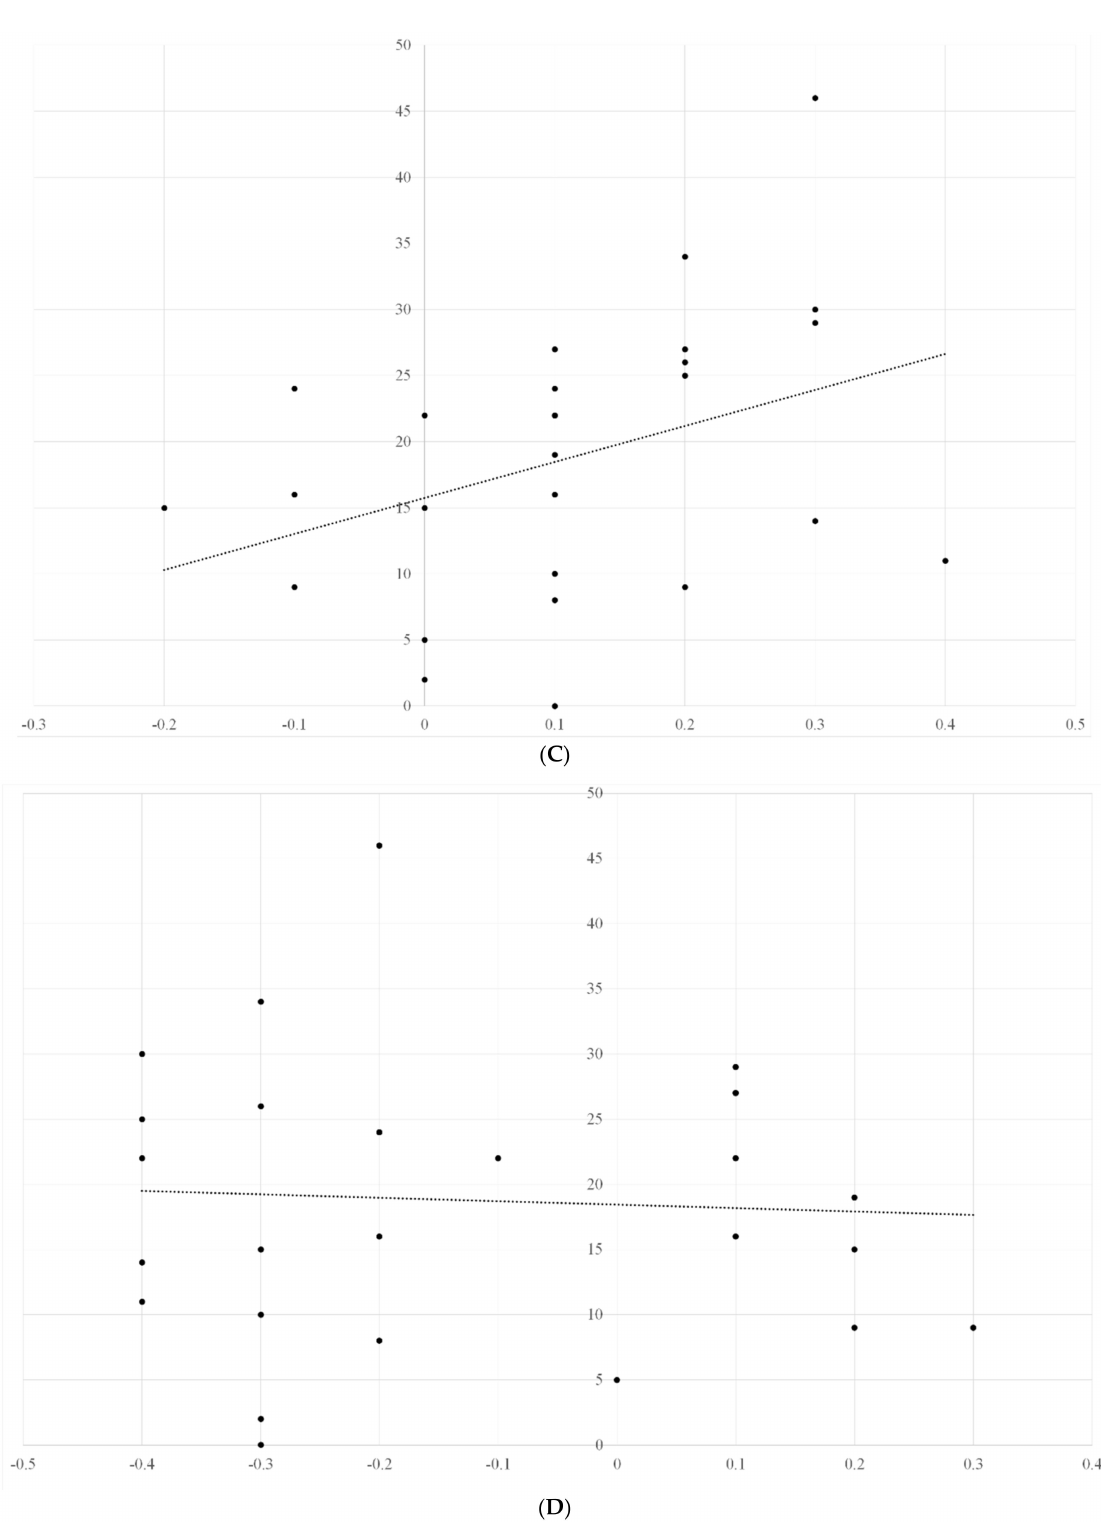
Figure 2. ( A ) Relationship between changes in nutritional status and ADL recovery in male patients; ( B ) relationship between changes in muscle strength and ADL recovery in male patients; ( C ) rela- tionship between changes in muscle quality and ADL recovery in male patients; ( D ) relationship between changes in SMI and ADL recovery in male